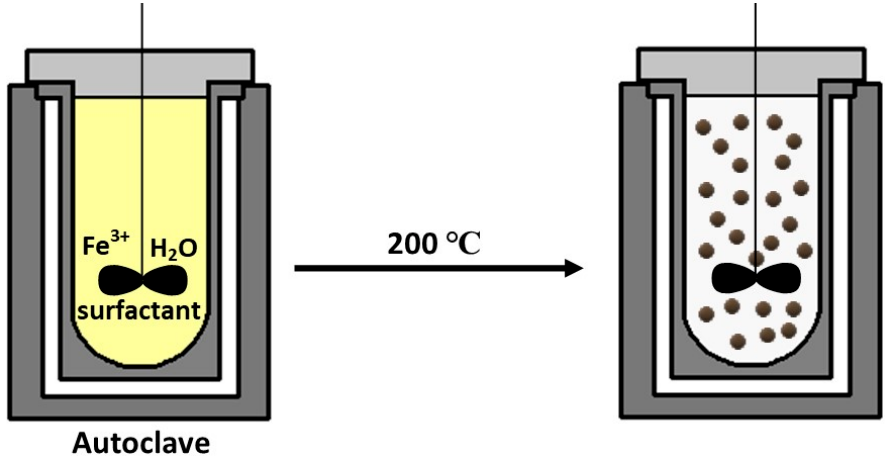
Figure 4. Schematic synthesis of magnetite nanoparticles by the hydrothermal method.